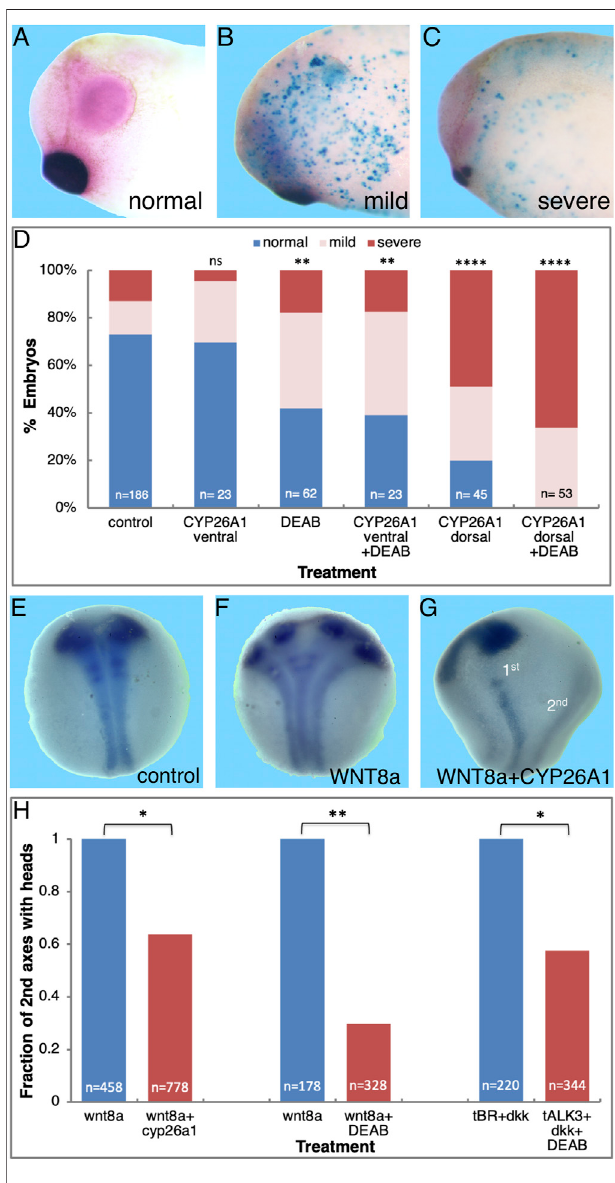
FIGURE 1| Retinoicacidisrequiredfornormalheaddevelopment.Embryos were injected with RNA encoding CYP26A1 and treated with DEAB to reduce the endogenous levels of RA. (A) Control embryo (st. 30) processed for in situ hybridization with pax6 (eyes, pink) and muc2 (cement gland, purple) speci fi c probes. (B) Embryo injected dorsally with cyp26a1 RNA exhibiting mild microcephaly.Turquoisestainingisthe LacZ lineagetracer. (C) Severemicrocephaly in an embryo injected with cyp26a1 mRNA in the dorsal region. (D) Frequency of microcephalyinductionbycombinedRAknockdowninembryosinjecteddorsallyor ventrally with cyp26a1 RNA and treated with DEAB. (E) Control st. 14/15 embryo processed for in situ hybridization with pax6 (eyes) and ncam (neural plate). (F) Embryo ventrally injected with wnt8a RNA to induce a secondary axis analyzed for eye and neural plate formation. (G) Loss of anterior head structures (eyes, pax6 ) in the induced secondary axis by co-injection of cyp26a1 RNA with the wnt8 mRNA. Theprimaryandsecondaryaxesarelabeled(1 st ,2 nd ). (H) Inhibitionofanteriorhead formationintwinnedembryosinducedbyventral wnt8a injectionorparallelinhibition of BMP (tALK3) and Wnt (DKK1) signaling and reduction of RA levels (DEAB treatmentorCYP26A1overexpression).Theoverallnumberofembryosinjectedor manipulatedisshown( n =).*, p < 0.05;**, p < 0.01;****,0.0001;ns,notsigni fi